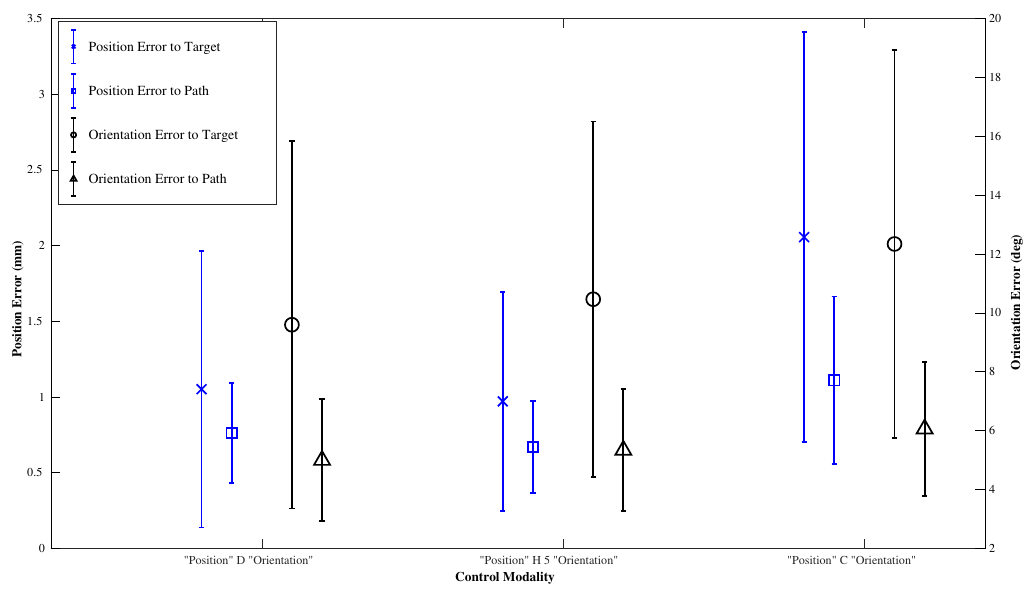
Figure 14. Performance results for the user